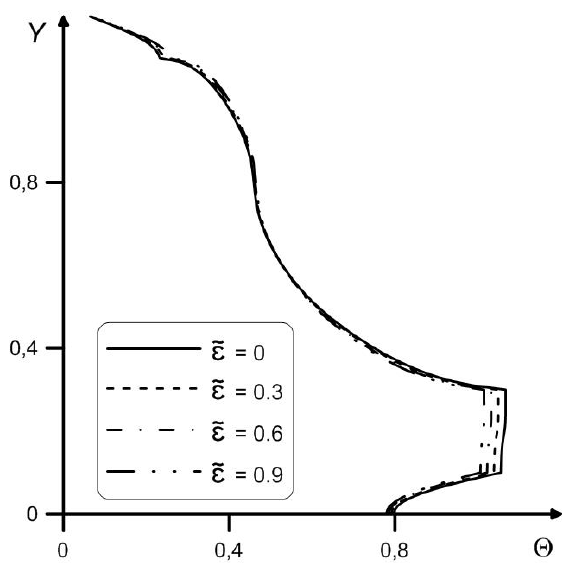
Figure 7. Temperature profiles at X = 0.6, Ra = 10 9 , Os = 1 and different values of surface emissivity.